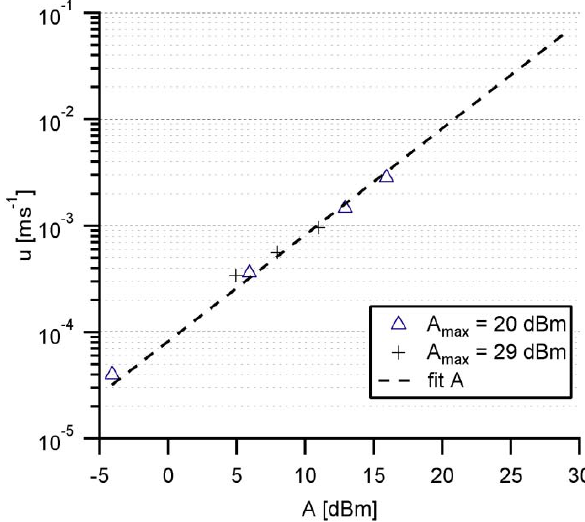
Figure 4. Experimentally determined streaming velocity u plotted on log-scale as the function of acoustic level A , obtained from two sets of experiments at A 29 dBm, respectively.